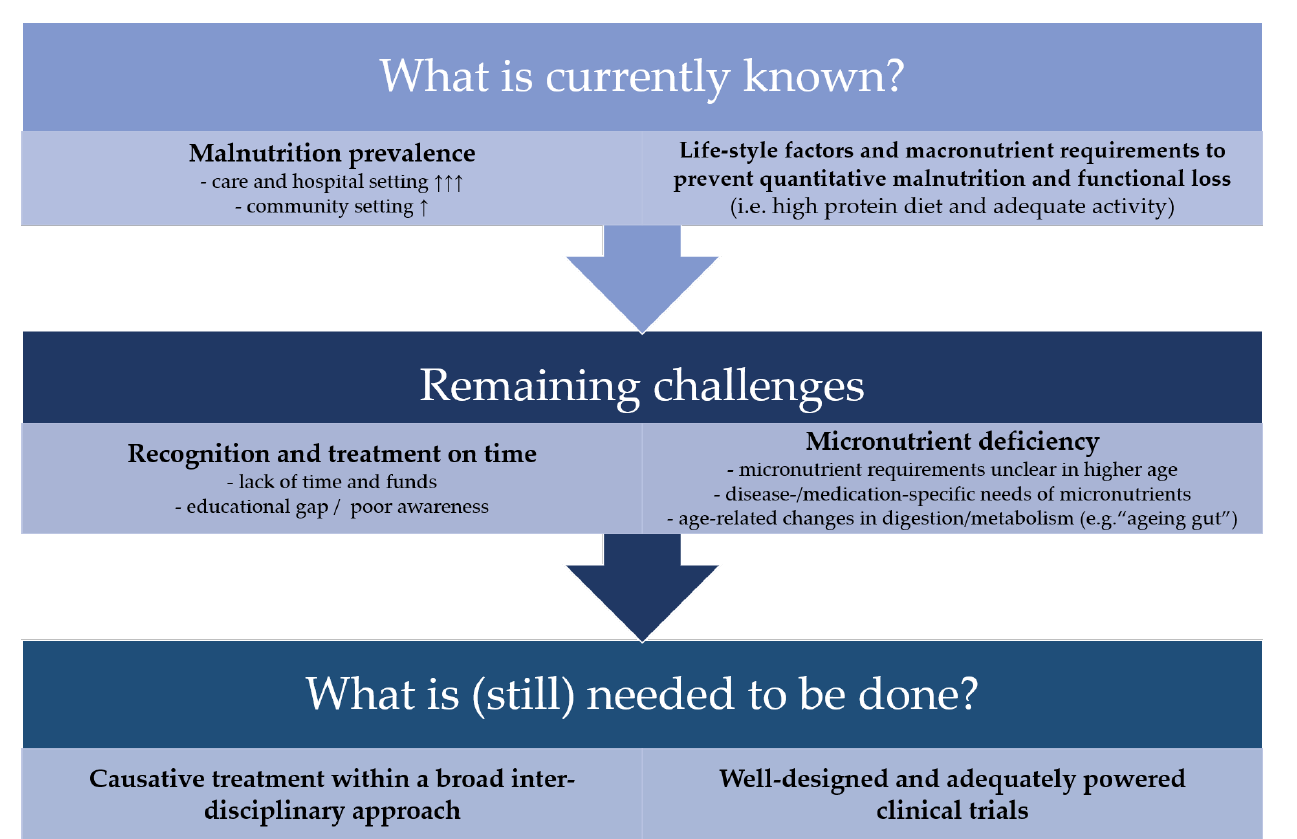
Figure 2. Remaining challenges in the effective prevention and sustainable treatment of malnutrition in old adults. ↑↑↑ indicates a high prevalence, whereas ↑ indicates a lower prevalence.